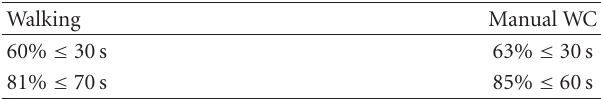
Table 7: Comparison of typical bouts in walking (Orendur ff et al. [7]) compared with manual wheelchair